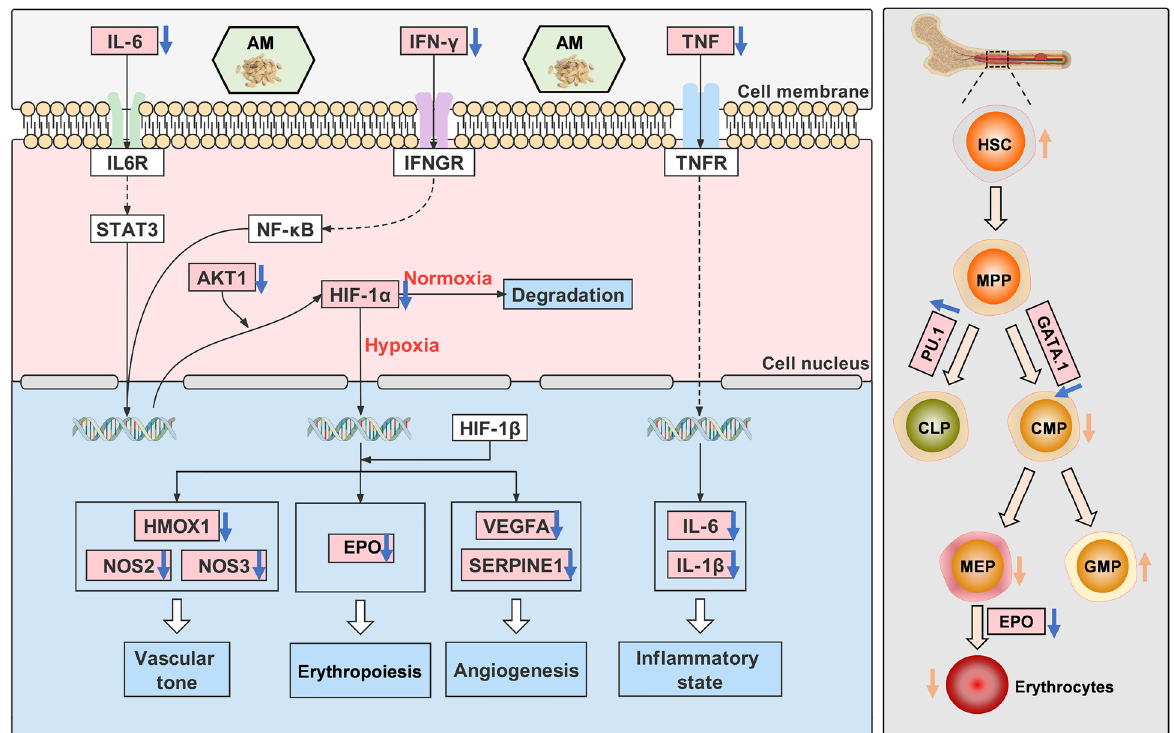
Figure 12. The mechanisms of HAPC alleviation by AM in hypoxia. The regulation of genes by AM is represented by blue arrows, and the regulation of cells by AM is shown by orange arrows, with upregulation denoted by an up arrow and downregulation by a down arrow. Compared with the Hypoxic group.